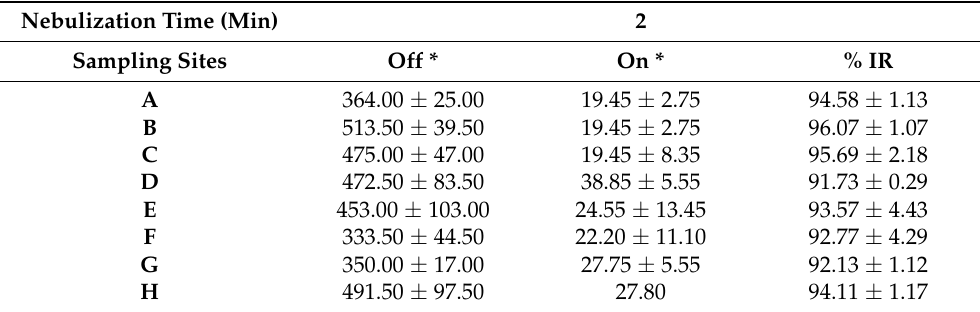
Table 2. E. coli concentrations (CFU/m 3 ± SD) in air sampled downstream of the sanitation system in the train setting. Inactivation percentages (% IR ± SD) are reported.